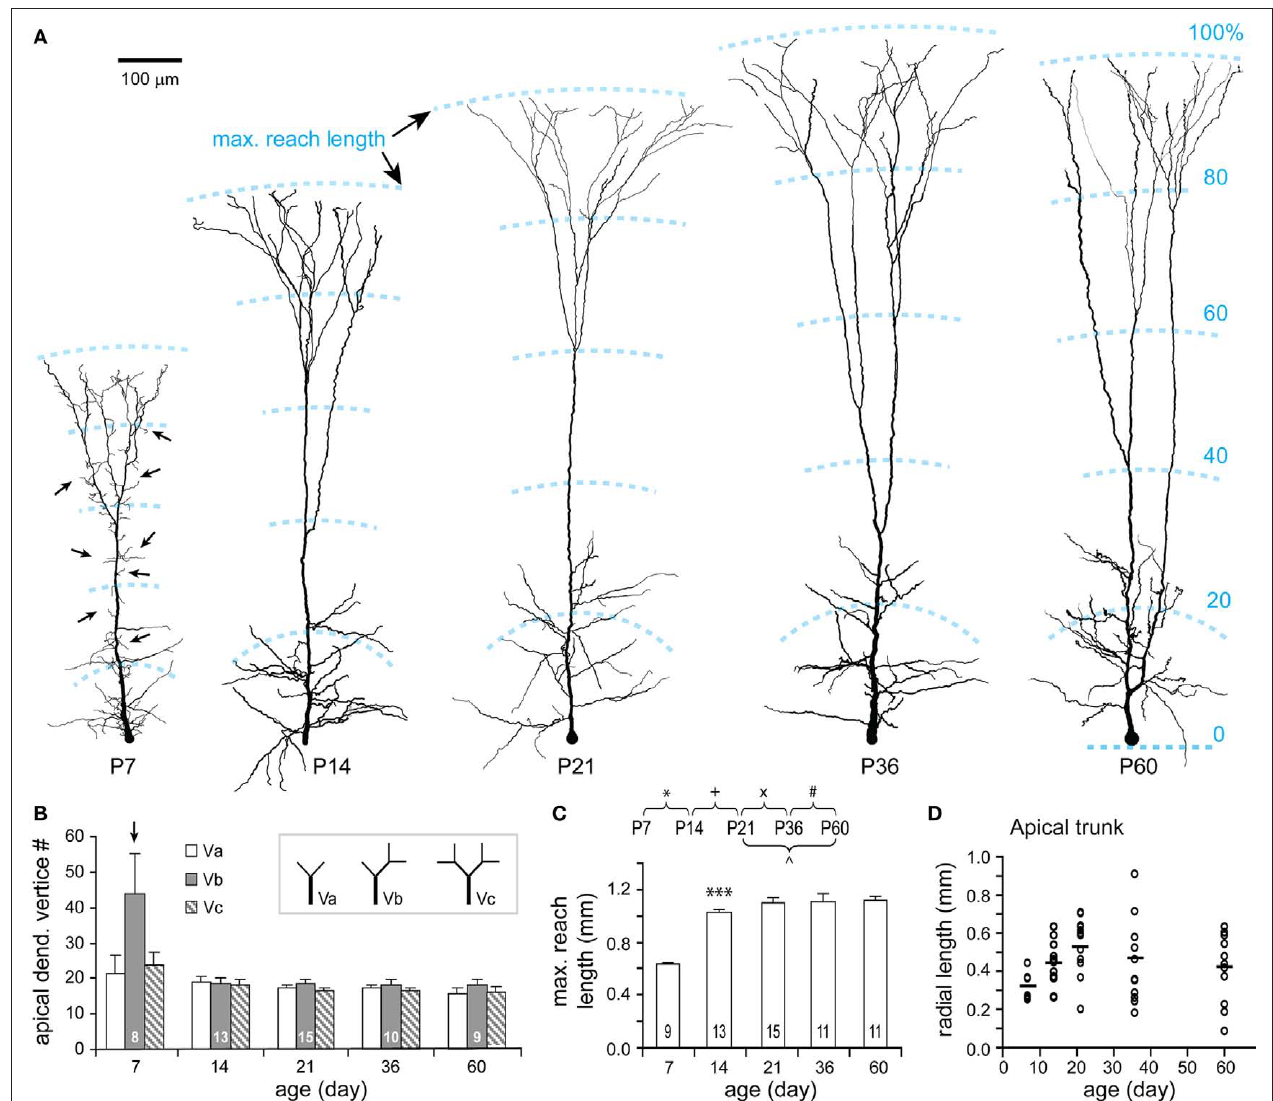
was presented at P7. Otherwise, there were no significant changes in the three types of vertices through all ages. (C) The maximal reach length of apical dendrite significantly increased from P7 to P14, and thereafter remained constant. (D) The radial length of apical trunk (from the soma to the first tuft bifurcation) showed a large variation at each age (empty circles, P7: n = 8, P14: n = 15, P21: n = 15, P36: n = 13, P60: n = 12; horizontal bars: mean